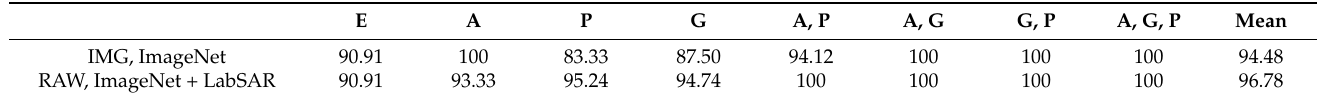
Figure 12. Average test mAP of the RAW and IMG pair of models for each combination of weight initialization scheme and training set size. Table 6. Per-class F1 scores and the macro F1 score for the best threshold values on the validation set. E—Empty, A—Aluminium, P—Plastic, and G—Glass.